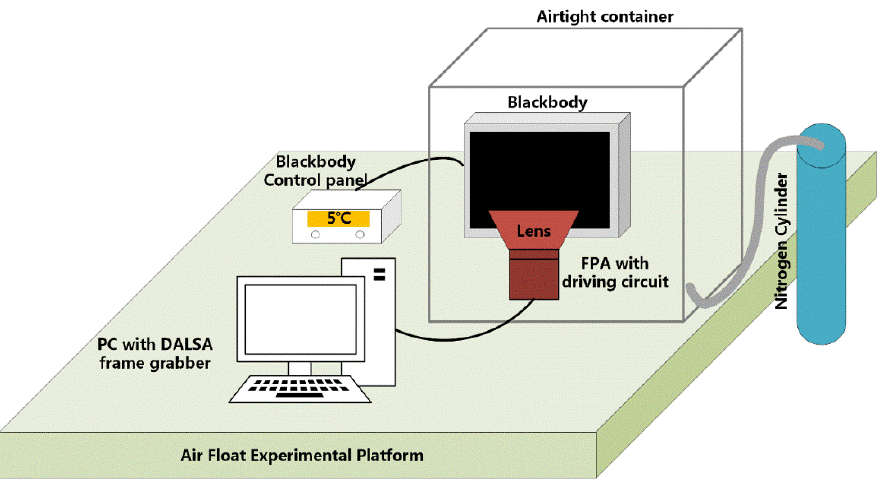
Figure 4. Schematic diagram of the laboratory calibration experiment.